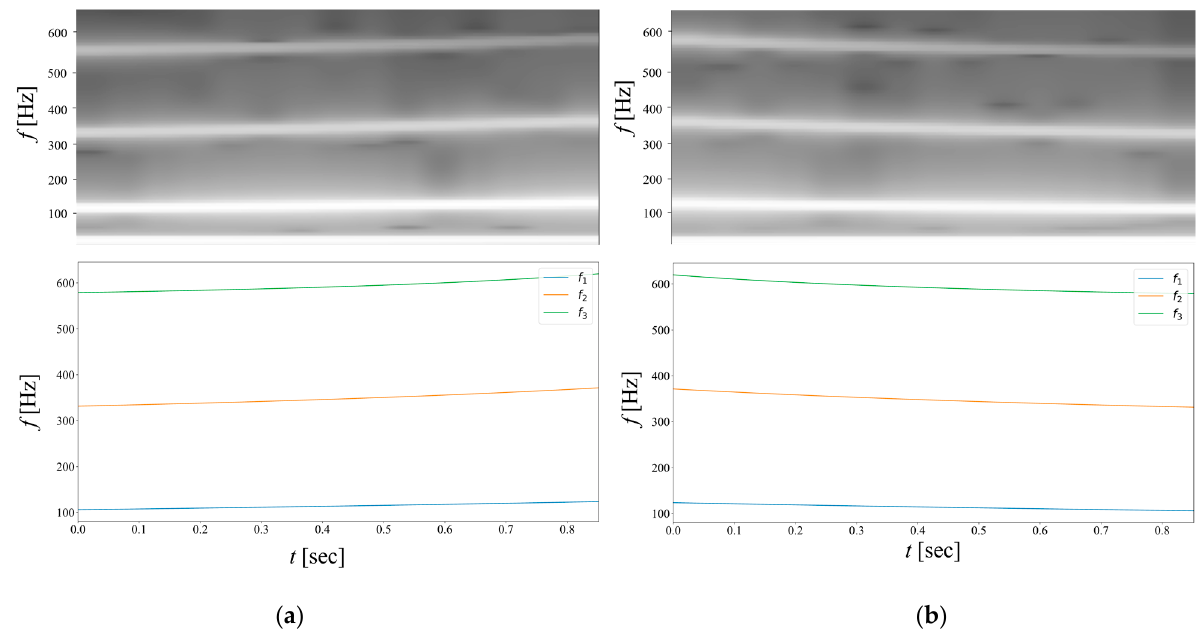
Figure 7. First three pylon-variable mass structural system eigenvalues: ( a ) negative mass rate 𝜇 = −1.0 (𝑡𝑛/𝑠) and ( b ) positive mass rate 𝜇 = 1.0 (𝑡𝑛/𝑠) : Top graphs derive from a Runge–Kutta solution of the equations of motion; bottom graphs derive from the iterative methods of solution of the eigenvalue problem.